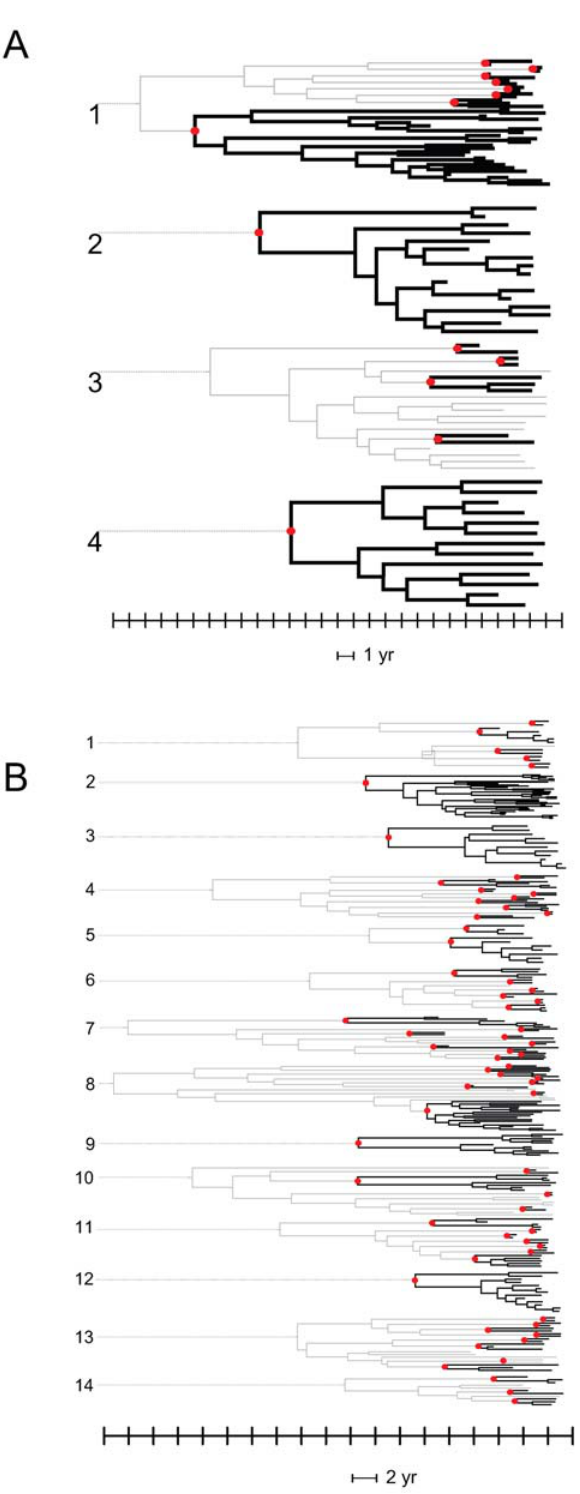
Figure 1. Time-scaled Bayesian MCMC phylogenies of clusters of $ 10 patients. Red dots indicate the most recent common ancestor (MRCA) of UK transmission clusters as defined against analysis with global diversity. The scale bar is in calendar years. Grey lines indicate non-UK-based segments of the phylogeny, black lines indicate UK- based lineages. A) Subtype A. Scale bar indicates calendar years. B) Subtype C. Scale bar indicates 2 calendar years.